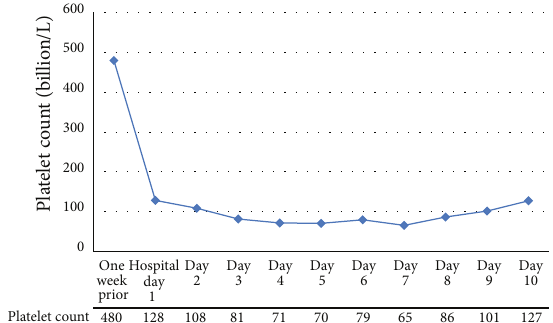
Figure 1: Case of patient’s platelet trend showing initial point one week prior to admission where ciprofloxacin was changed to lev- ofloxacin,aswellastrendthroughouthospitalstay.Levofloxacinwas changed to cefepime on hospital day